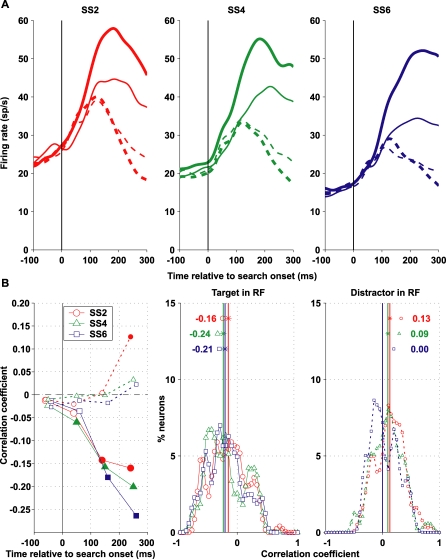
Correlations between Firing Rate and Reaction Time within Each Set Size(A) Population firing rates averaged for trials with responses shorter and longer than the median (thick and thin traces) for the target or distractors in the RF (solid and dashed traces).(B) Correlation coefficients between firing rates and reaction time. Left panel shows the population correlation coefficient computed in 100 ms time bins when the target (solid lines) or a distractor (dashed lines) was in the RF, at set-size 2, 4, or 6. Filled symbols indicate statistically significant values (p < 0.05). Middle and right panels show the distribution of coefficients from individual neurons between 200 and 300 ms after search display onset when the target or a distractor was in the RF. Vertical lines and numbers indicate medians; the star represents p < 0.05 relative to 0.